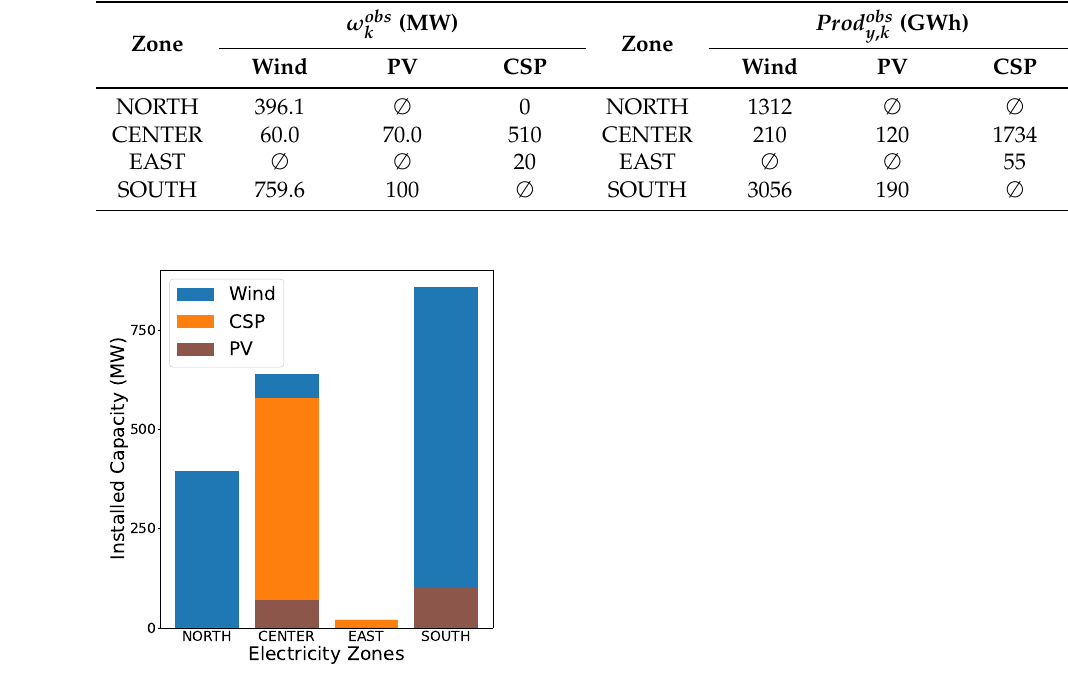
Table A1. Reference capacities, ω obs , (Left) and yearly-mean generation, Prod obs k and technology installed in Morocco in 2018 ([51], Table A4). Zone–technology pairs for which no capacity is installed are marked by an empty set ∅ .